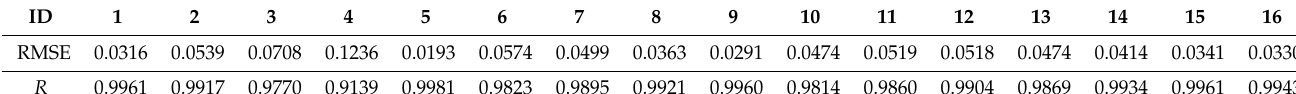
Table 1. RMSE and R of selected model testing results shown in Figure 4.